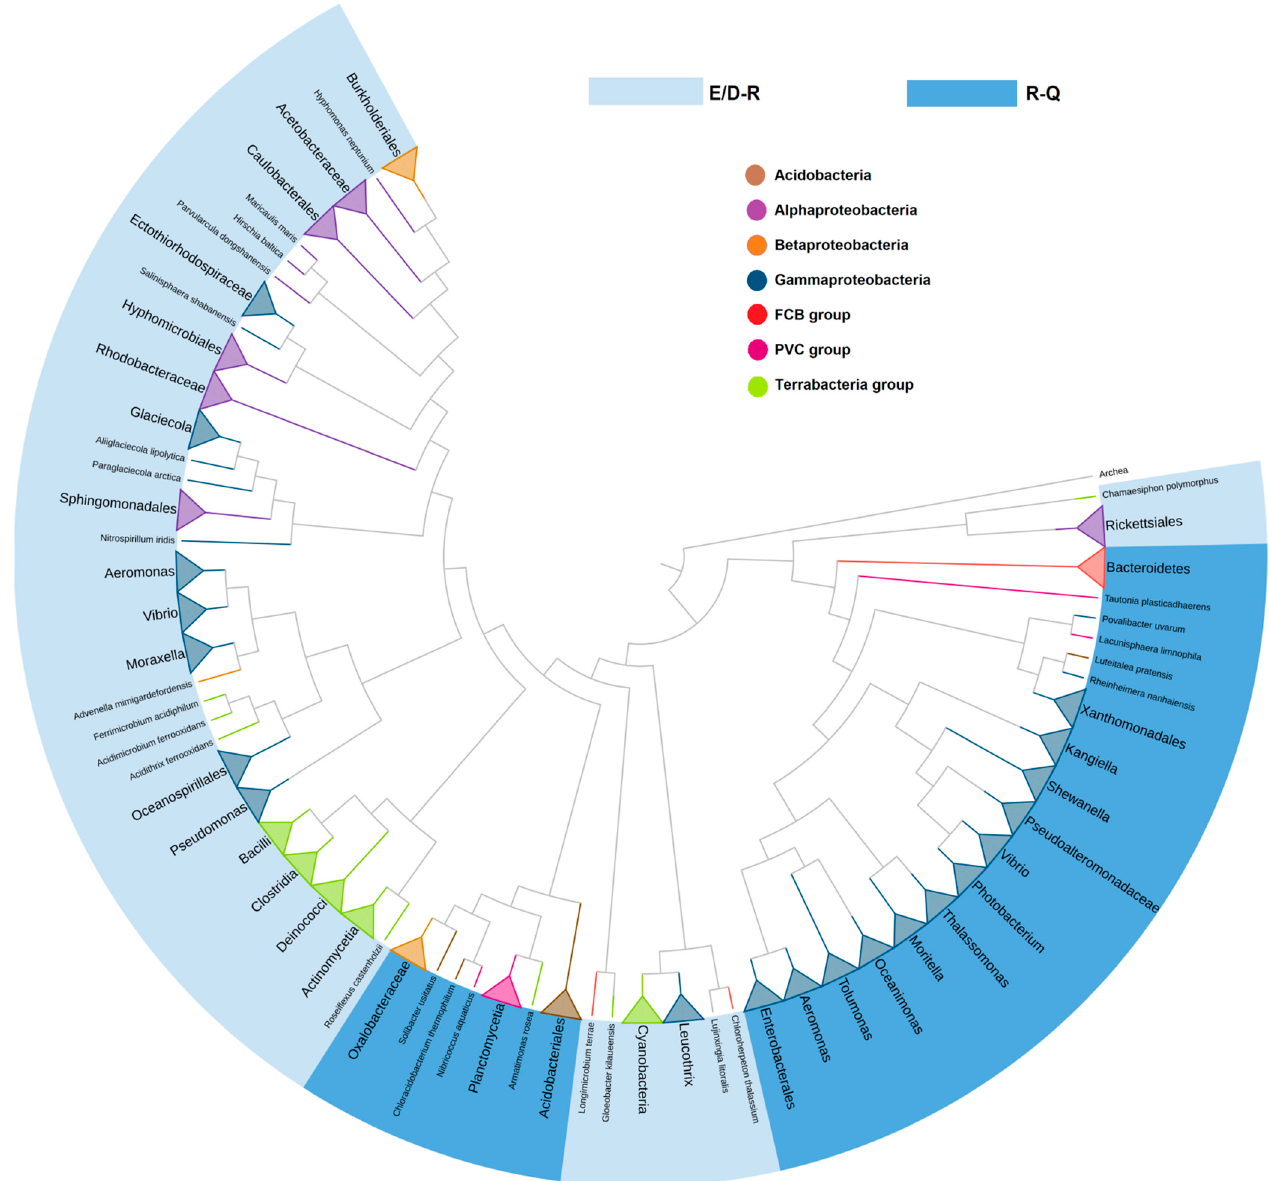
Figure 2 . Two independent clusters of SpOpB-like sequences carrying the R-Q amino acid combina- tion are found by a phylogenetic analysis of 1364 bacterial OpB sequences.